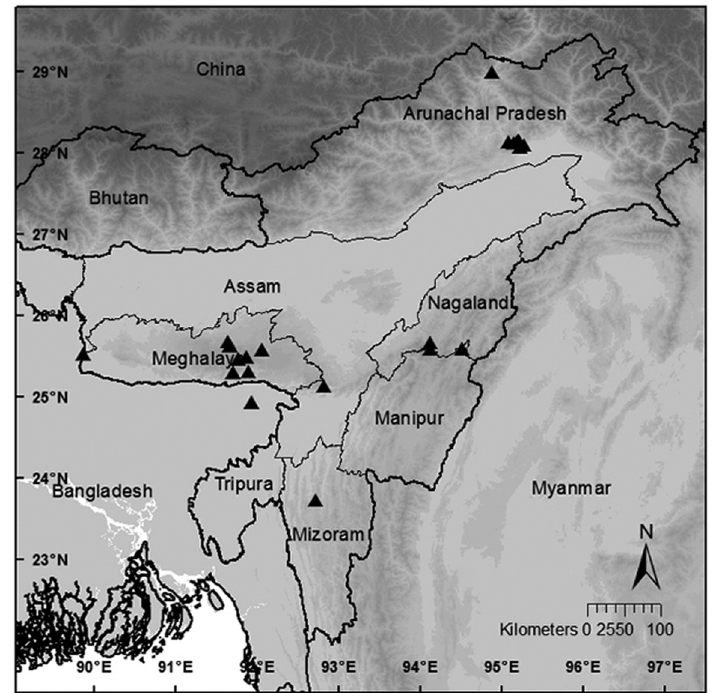
Fig. 45. Map showing the location of B. palmata D.Don